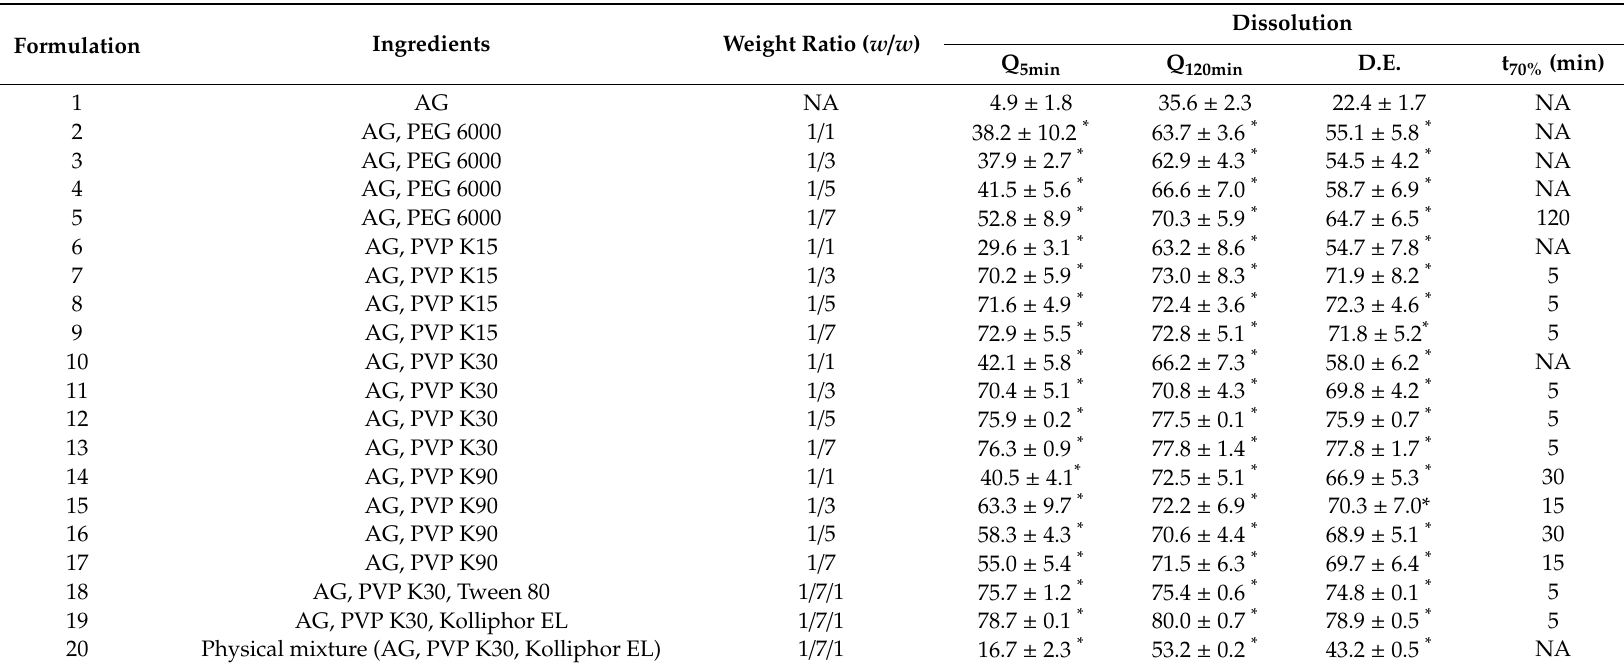
Table 1. Ingredients, weight ratios, and dissolution performance of andrographolide (AG) and AG-loaded solid dispersion formulations.